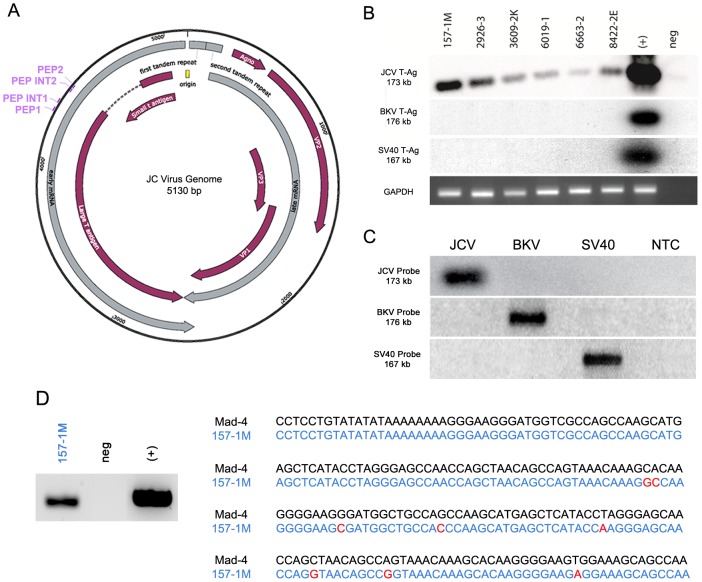
Amplification of JCV T-Antigen genome in colon cancer samples.A schematic representation of the Mad-1 strain of the JCV genomic structure showing viral genes in red, early and late transcripts in grey, and the locations of primers used for T-Antigen amplification (PEP1 and PEP2) and Southern blot probe synthesis (PEP INT1 and PEP INT2) (Panel A). Genomic sequences of the viral early region, which encodes T-Antigen, were detected in 28 of 34 selected samples. A representative Southern blot is presented, with case numbers above each lane. Negative results were observed when the same cases were tested with probes for BKV and SV40. Negative controls show results from reactions containing no DNA and positive control represents gene amplification using pBJC, a plasmid containing JCV DNA as a template or plasmids containing BKV and SV40 T-Antigens. PCR for GAPDH and agarose electrophoresis was used to confirm the presence of intact genomic DNA in all cases. (Panel B). Southern blots of plasmids containing the T-Antigen of JCV, BKV and SV40 were tested with specific probes for each polyomavirus, demonstrating the specificity of the probes (Panel C). A representative Southern blot of PCR amplification of the control regulatory region is shown (Panel D, left). Sequencing revealed the presence of Mad-1 and Mad-4 strains with point mutations in the different samples. A representative sequence is shown in blue, underneath the known sequence of the Mad-4 CR region (black); point mutations are highlighted in red (Panel D, right).